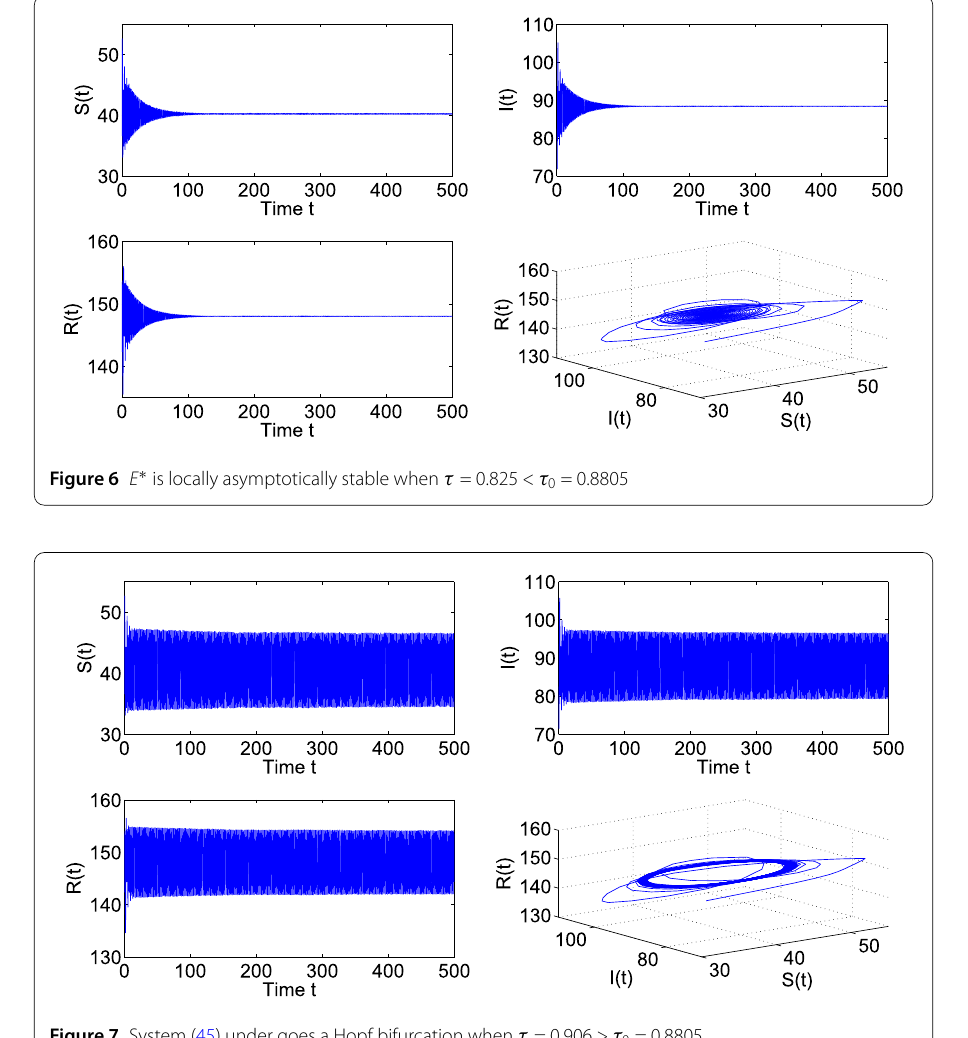
Figure 7 System (45) under goes a Hopf bifurcation when τ = 0.906 > τ 0 = 0.8805